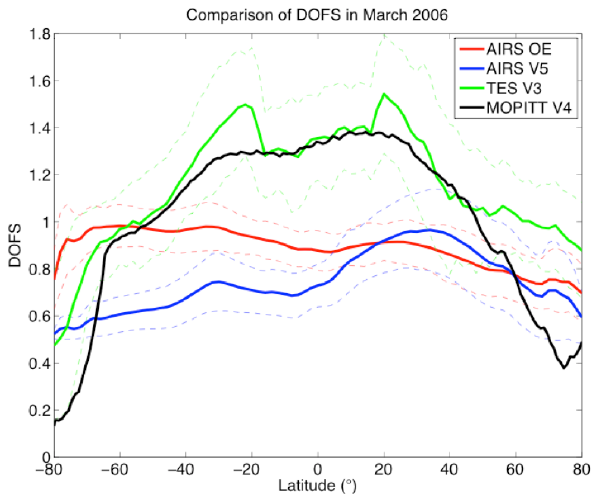
Figure 9 Fig. 9. An example of the DOFS for March 2006 for AIRS V5 CO (blue), AIRS OE CO (red), TES CO (green) and MOPITT CO (black), respectively, where the solid lines are the averaged DOFS in 10-degree latitude bands and the dashed lines represent the max- imum and minimum DOFS values in each